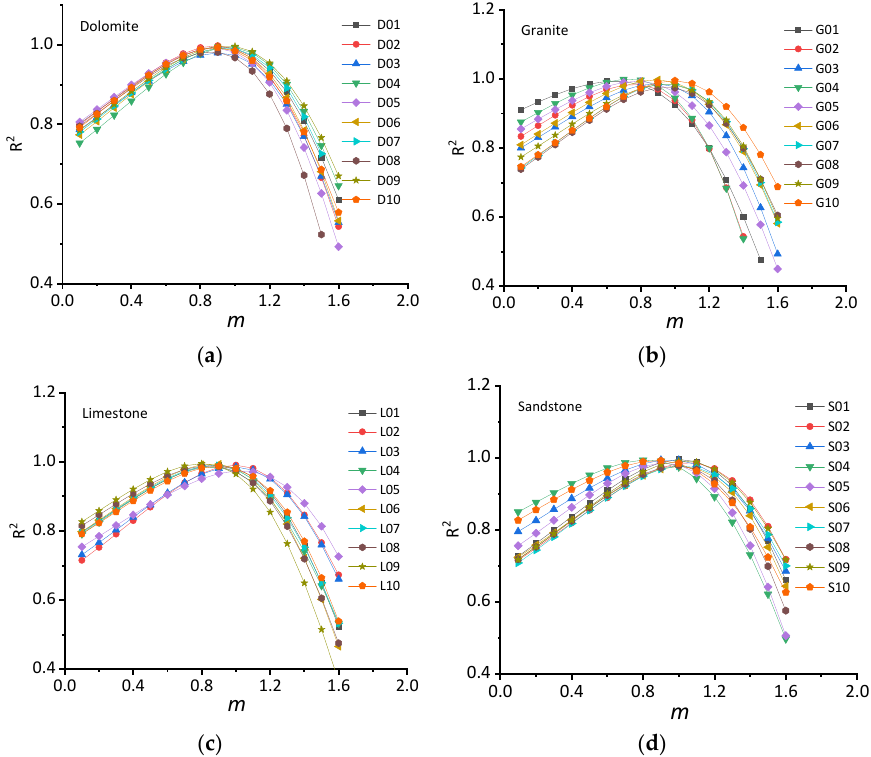
Figure 11. The R 2 values with different m values for different rock types. ( a —Dolomite; b —Granite; c —Limestone; d —Sandstone).